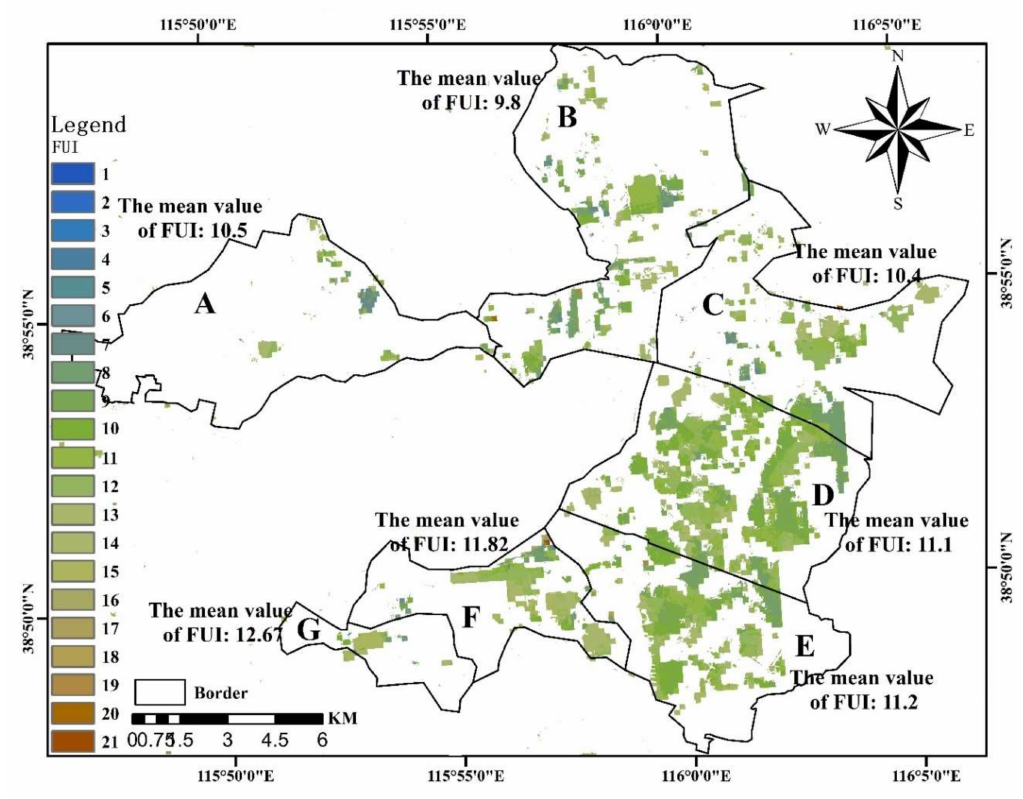
Figure 6. Spatial distribution of FUI in